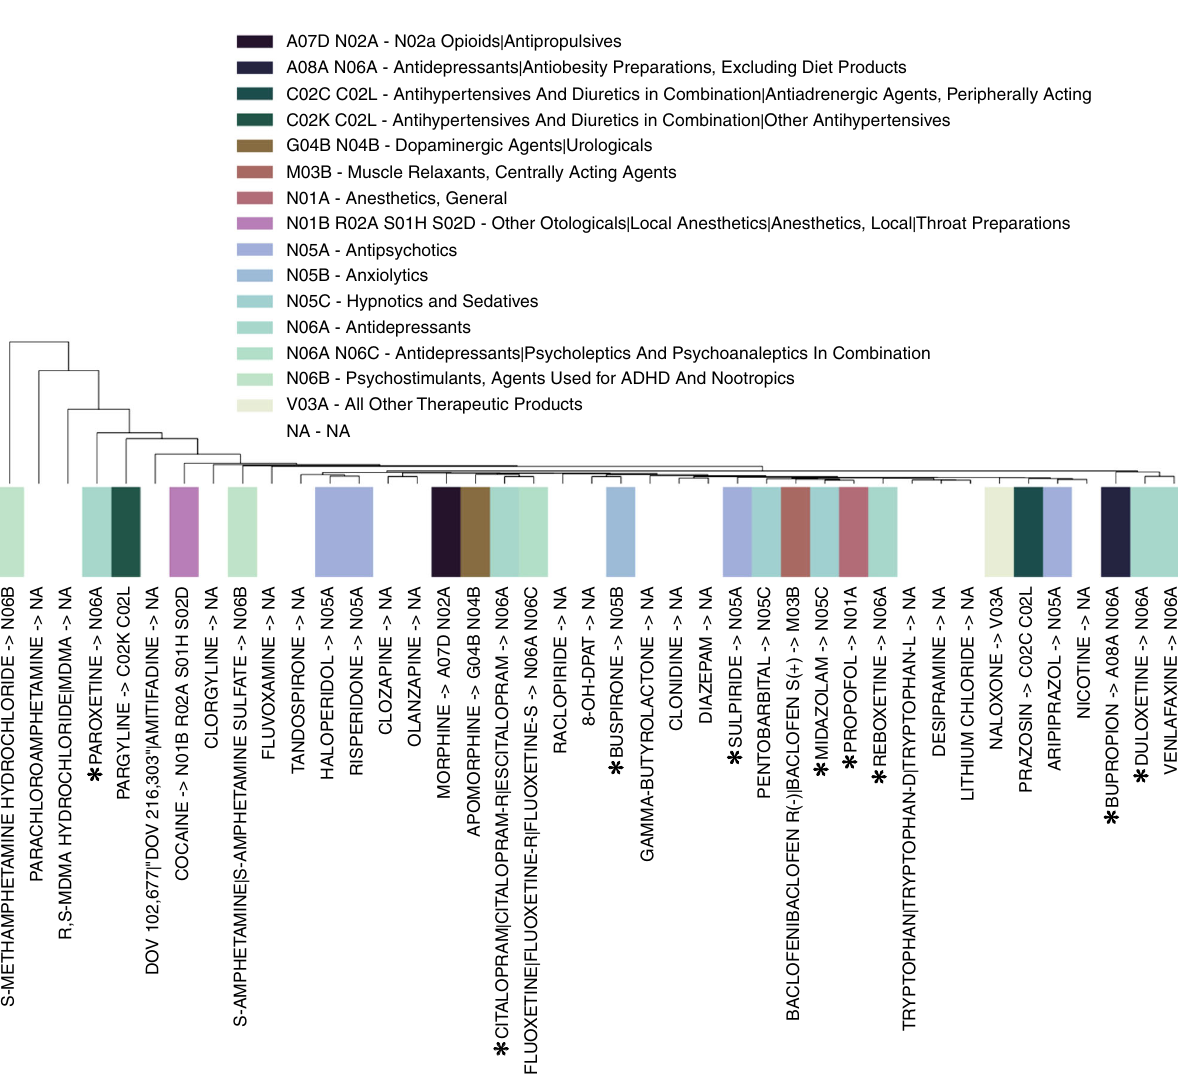
Fig. 4 Compound activity across brain regions and neurotransmitters. The analysis highlights that the historical classi fi cation of active ingredients of drugs (ATC codes) does not cluster well with their actual mode of action. There is little correlation between compound activity and codes which hence indicate that the current classi fi cation system is not exhaustive or complete. A subset of the compounds is shown here upon fi ltering the database for matrix completeness of 50%. ATC codes are shown using colour (key above). Compounds discussed in the main text are outlined using